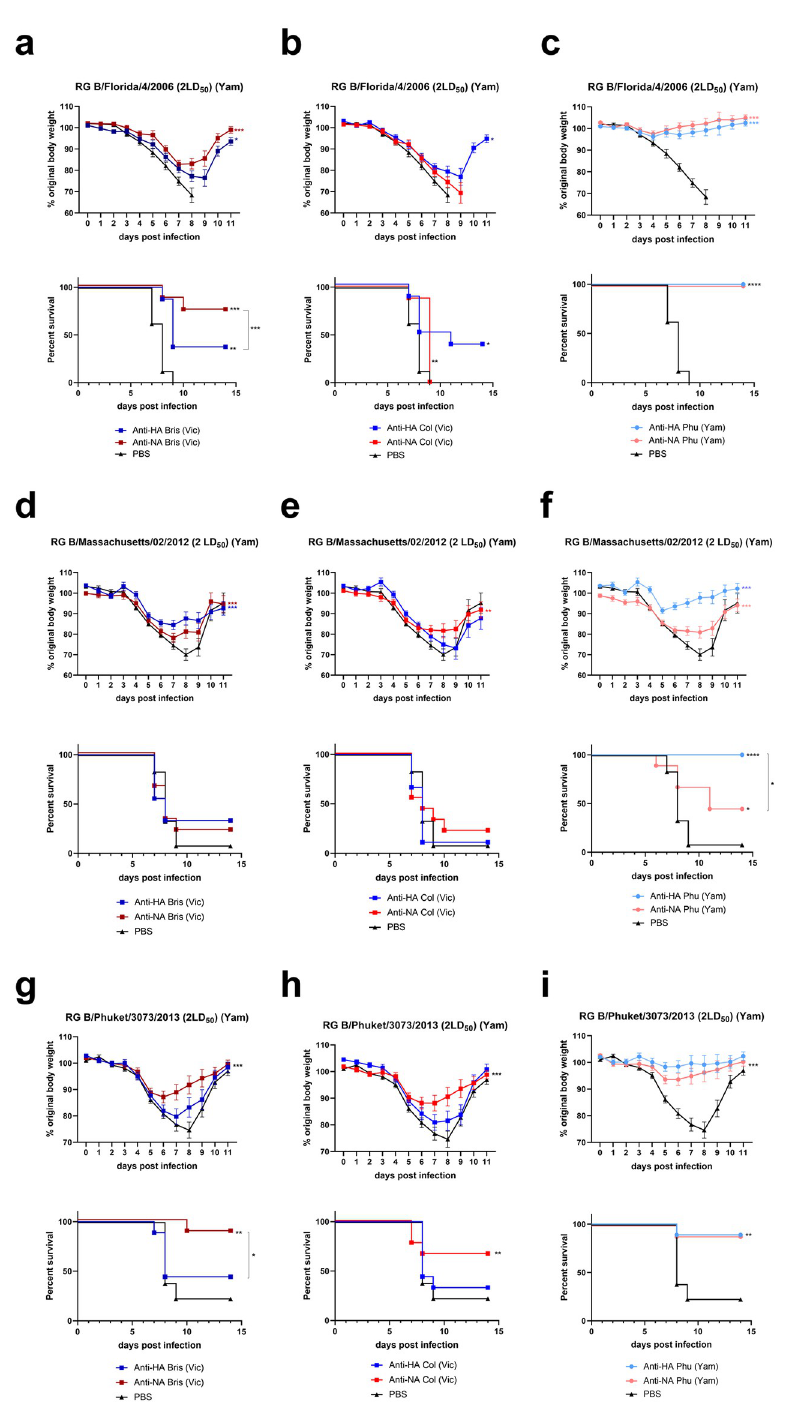
Fig 4. Cross protection provided by serum transfer against representative Yamagata lineage viruses. Mice were injected intraperitoneally with 16 μ l of serum raised against tetNA or HA from B/Brisbane/60/2008 (a, d and g), B/ Colorado/06/2017 (b, e and h), or B/Phuket/3073/2013(c, f and i). One day after intraperitoneal injection of serum, the mice were challenged intranasally with 2LD 50 of RG B/Florida/4/2006 (a-c), BALB/c mice), RG B/Massachusetts/02/ 2012 (d-f, DBA2/J mice), or RG B/Phuket/3073/2013 (g-i, BALB/c mice). Relative body weight values were analyzed as repeated measurements using method of residual maximum likelihood (REML). Survival analysis was done by the log- rank (Mantel-Cox) test. Data represent Significances: � P < 0.05; �� P < 0.01; ��� P < 0.001; ���� P < 0.0001). Each challenge experiment was repeated twice with 4–5 mice per group. The PBS group refers to data pooled from mice that received